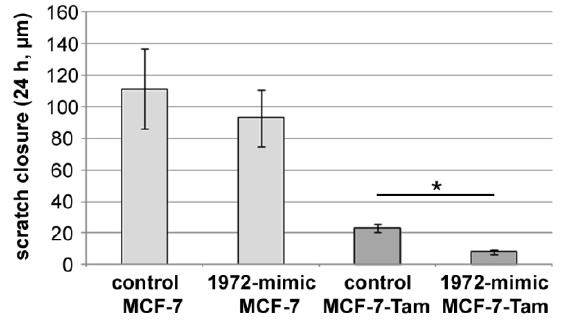
Figure 9. Effect of miRNA-1972 mimic transfection on migration as determined by scratch assay. MCF-7 and MCF-7-Tam cells were transfected and grown to confluence, as described in Materials and Methods. Average scratch closure after 24 h with standard error is shown. The experiment was repeated 4 times with 4 replicas each. (*: p < 0.05).